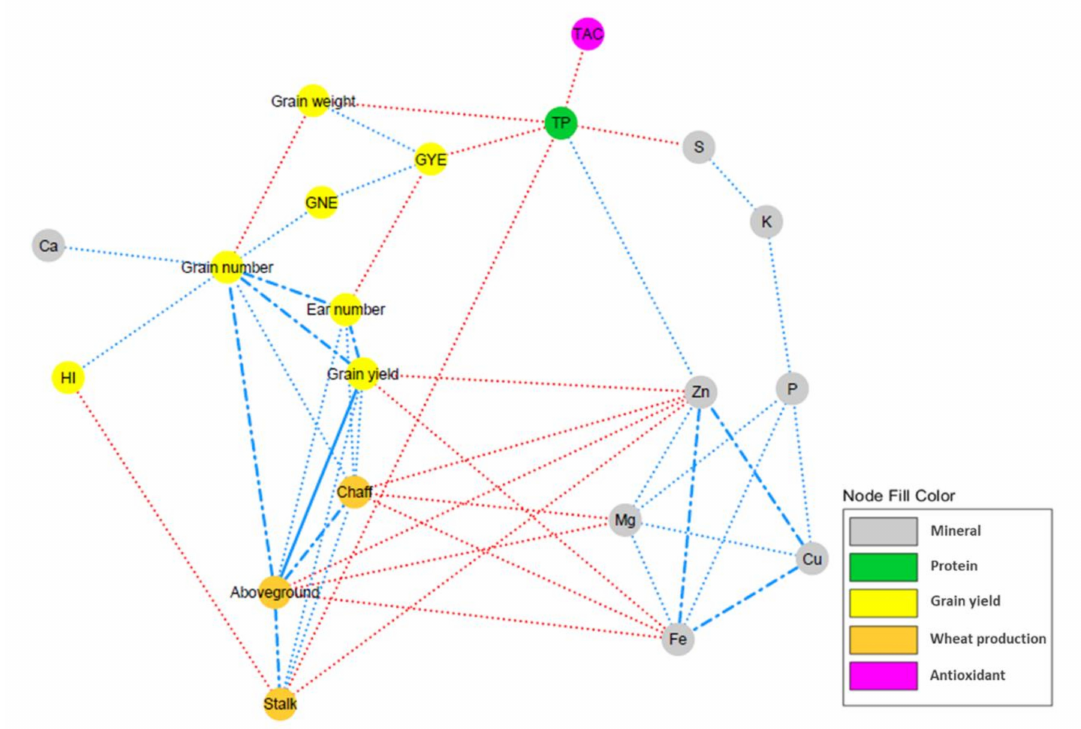
Figure 3. Overview of the correlation network for the wheat production, grain yield and nutritional quality traits of 10 wheat genotypes grown under elevated CO 2 and high temperature. GNE : grain number ear − 1 ; GYE : grain yield ear − 1 ; HI : harvest index; TAC : total antioxidant capacity; TP : total protein; TPhC : total phenolic compounds. The different traits (nodes) were classified by colors according to their grain yield or nutritional quality nature (see legend). Edges stand for a Spearman’s correlation r ≥ |0.45|, split up as dot (|0.65| > r ≥ |0.45|), dash and dot (|0.85| > r ≥ |0.65|) or solid (|1| > r ≥ |0.85|) line types. Blue edges indicate positive correlation whereas red edges implicate negative